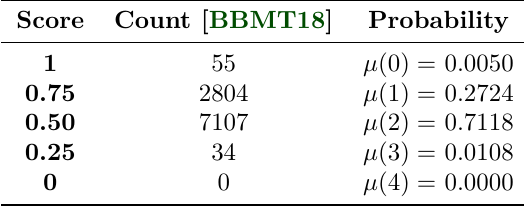
Table 3: Simulation results in [BBMT18] vs. our formula for nibble encodings.